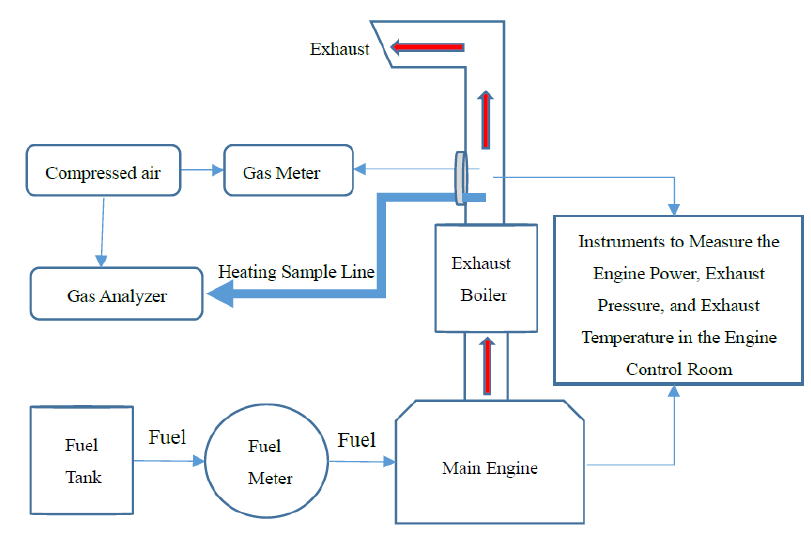
Figure 1. The emission measurement platform and the data acquisition scheme.